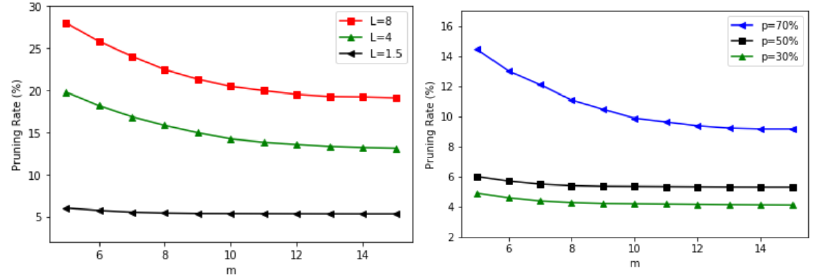
Figure 9. The pruning rate in the deterministic case where n = 20, s = 0%. For the left plot p = 50%, for the right plot L =